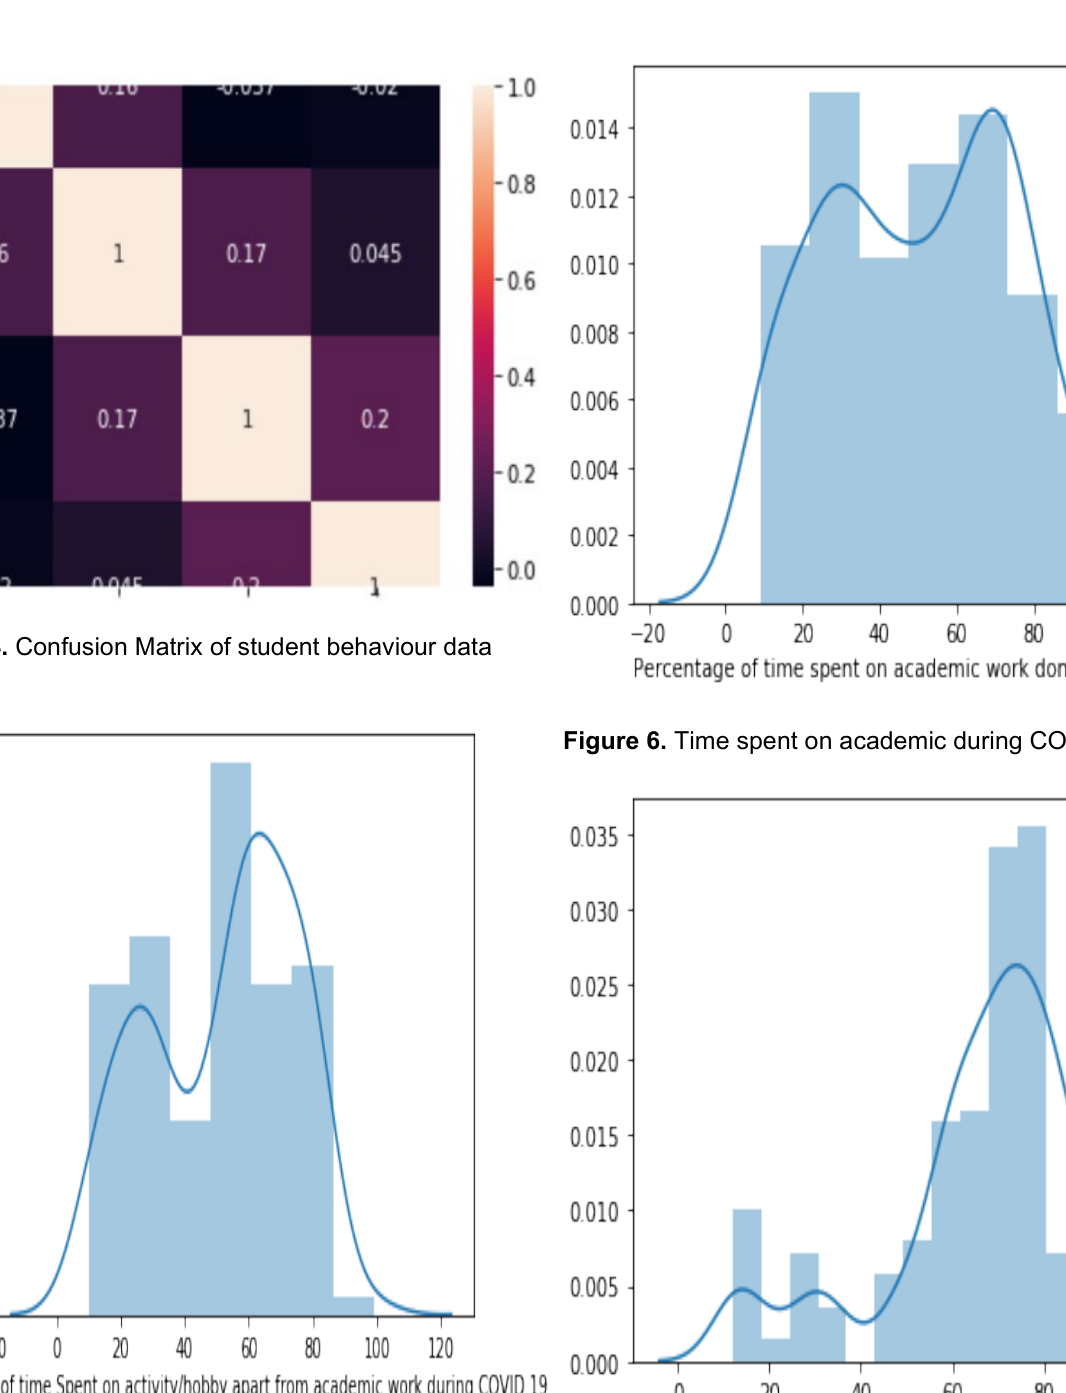
Figure 7. Time spent on academic before COVID